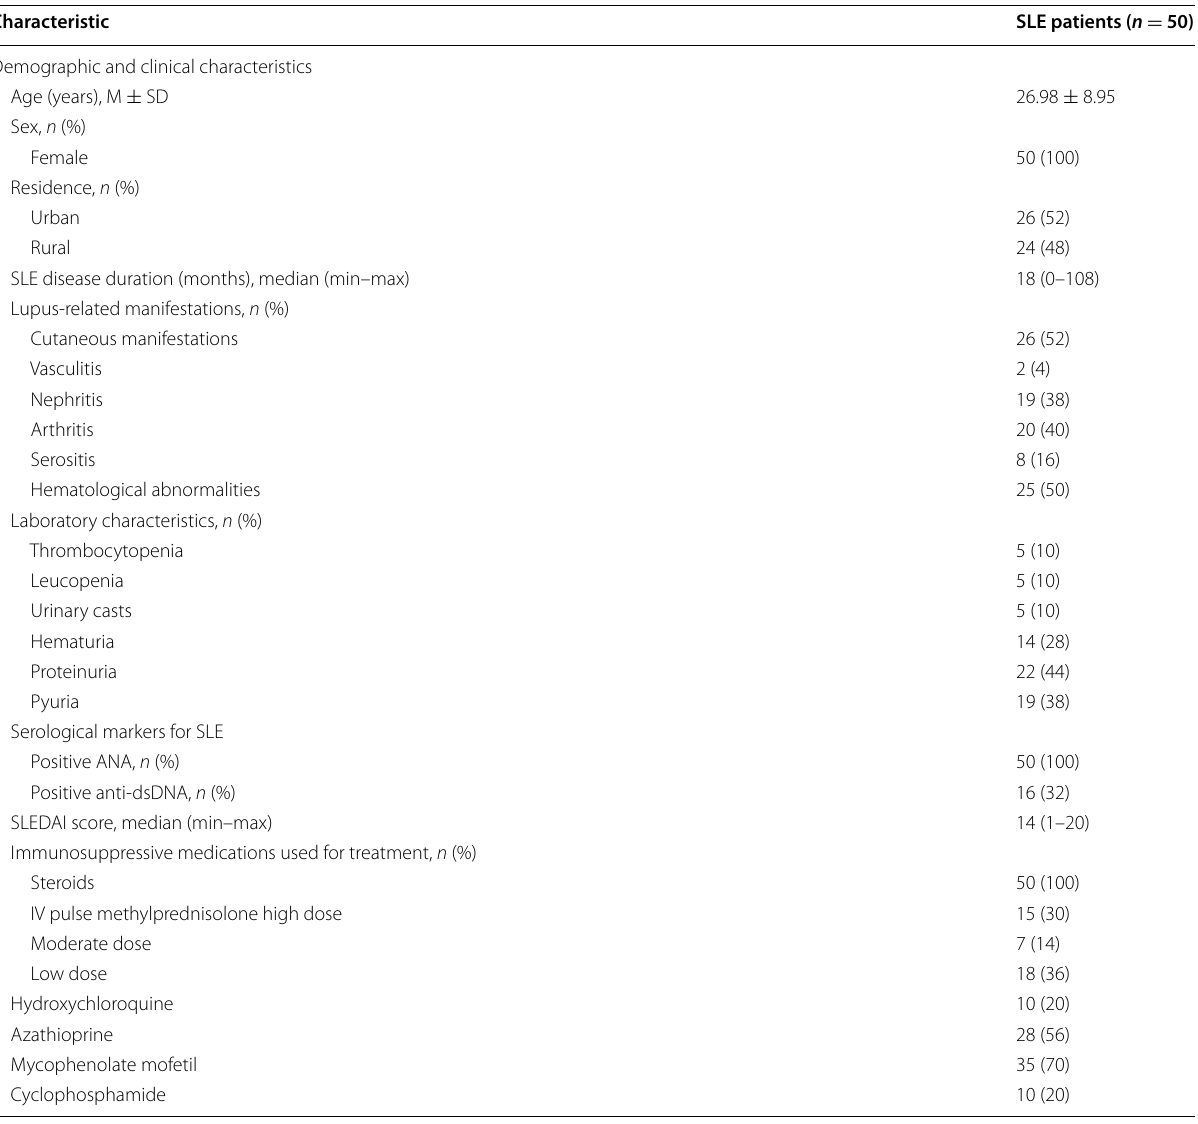
ANA antinuclear antibodies, anti-dsDNA anti-double-stranded DNA, SLE systemic lupus erythematosus, SLEDAI systemic lupus erythematosus disease activity index